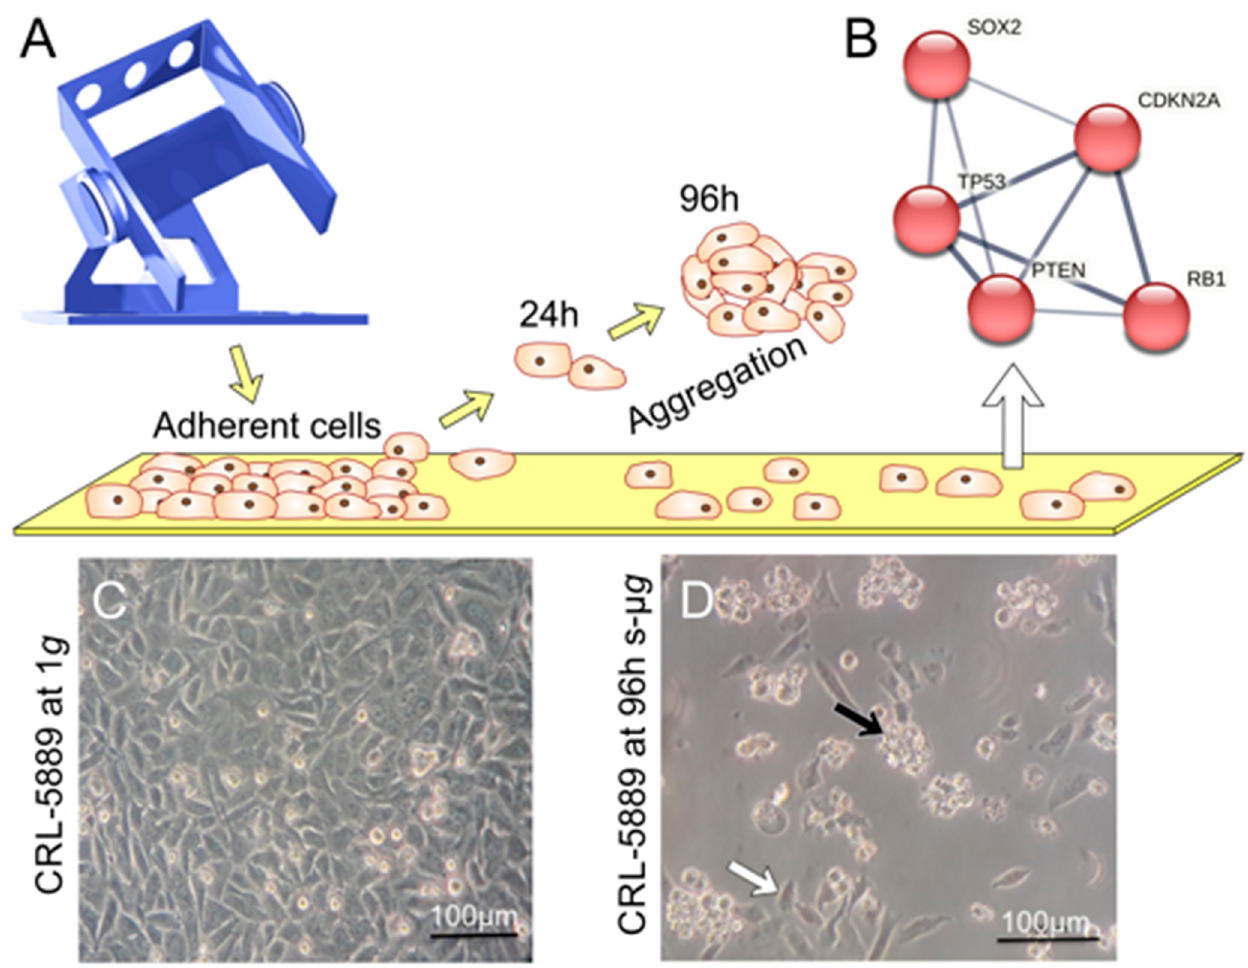
Figure 5. The effects of a four-day RPM exposure on the human squamous non-small-cell lung cancer cell line CRL-5889 according to Dietz and co-workers [196] ( A – D ). ( A ) The RPM exposure leads to partial detachment of cells from the bottom of the flask and after 24 h to first aggregations (spheroid formation) that further increase after 96 h. ( D , black arrow). However, one part of the cells remains attached to the bottom of the bottle ( D , adherent cells (AD), white arrow). These AD cells exhibit an upregulation of the PTEN , RB1 , TP53 , CDKN2A , and SOX2 gene expression, whose protein-to-protein interactions were shown by STRING analysis ( B ). In contrast under 1 g on 2D cell culture plate the cells stay in a state of near confluence ( C ). These results are published in